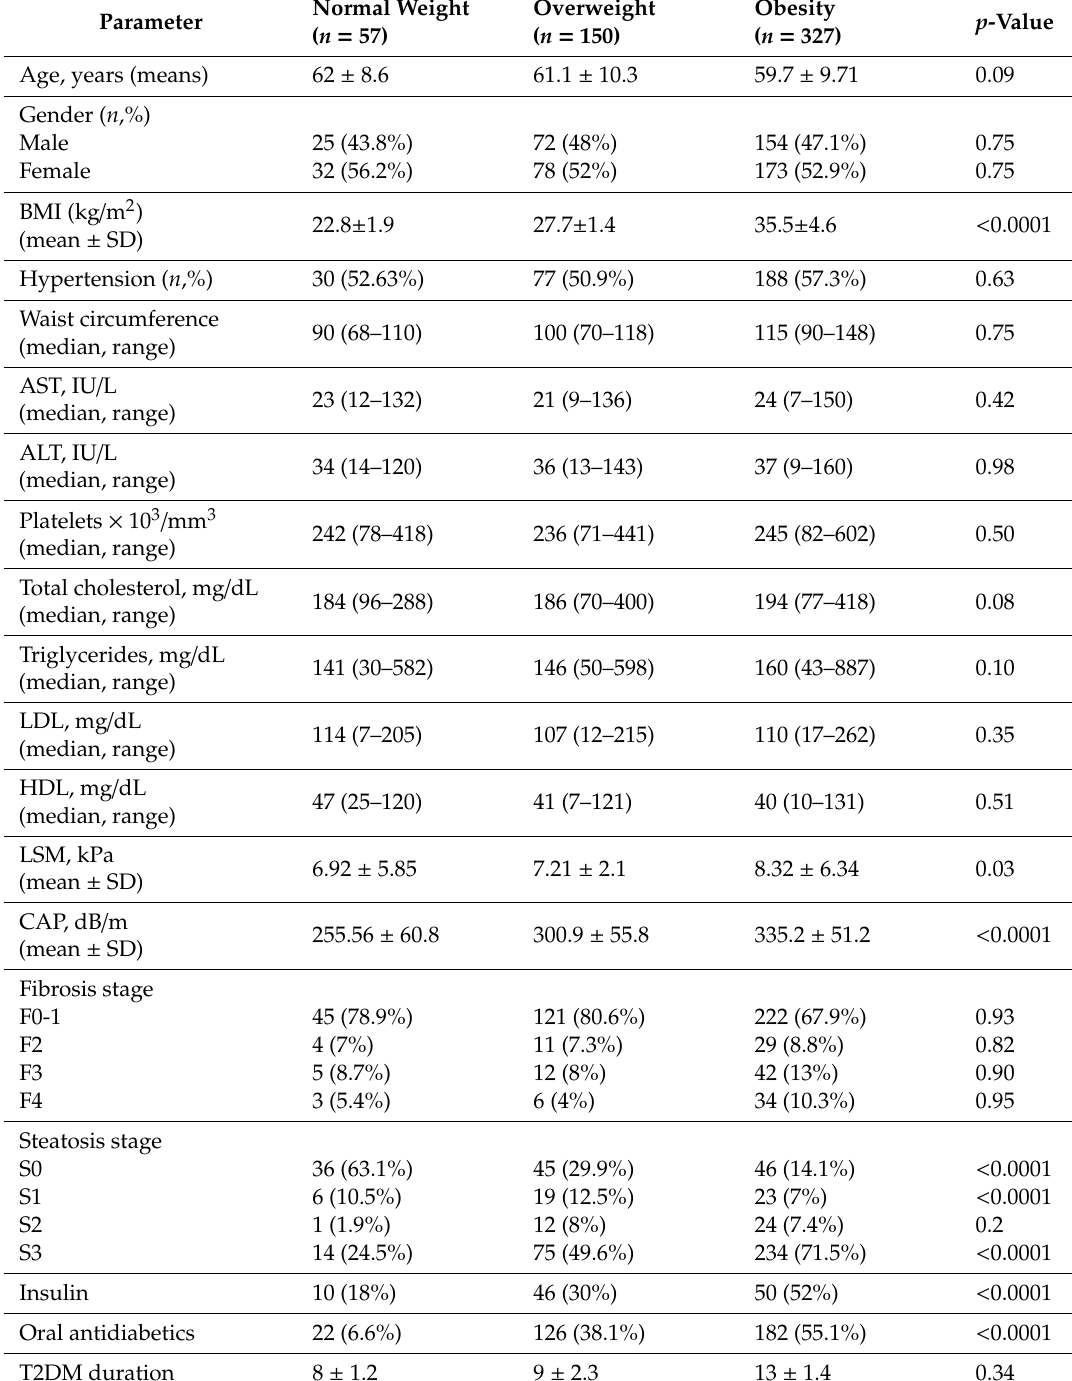
Table 2. Baseline characteristics of the study group according to weight